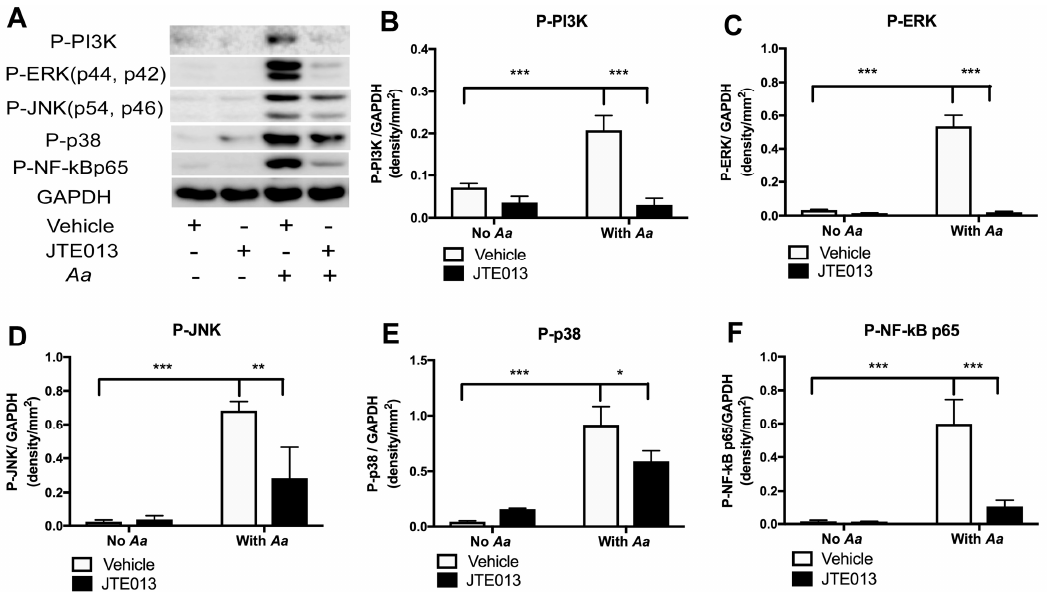
Figure 2. Inhibition of S1PR2 by its specific antagonist (JTE013) attenuated p-PI3K, p-ERK, p-JNK, p-p38, and p-NF-kBp65 protein expressions induced by Aa in BMMs. Murine BMMs were treated with either vehicle or JTE013 for 30 min. Then cells were either uninfected or infected with Aa for 4 h. ( A ) p-PI3K, p-ERK, p-JNK, p-p38, p-NF- κ Bp65, and control GPADH protein expressions were evaluated by western blot. ( B ) p-PI3K protein density, ( C ) p-ERK protein density, ( D ) p-JNK protein density, ( E ) p-p38 protein density, and ( F ) p-NF- κ Bp65 protein density were analyzed and normalized by GAPDH protein expression. (* p < 0.05, ** p < 0.01, *** p < 0.001).